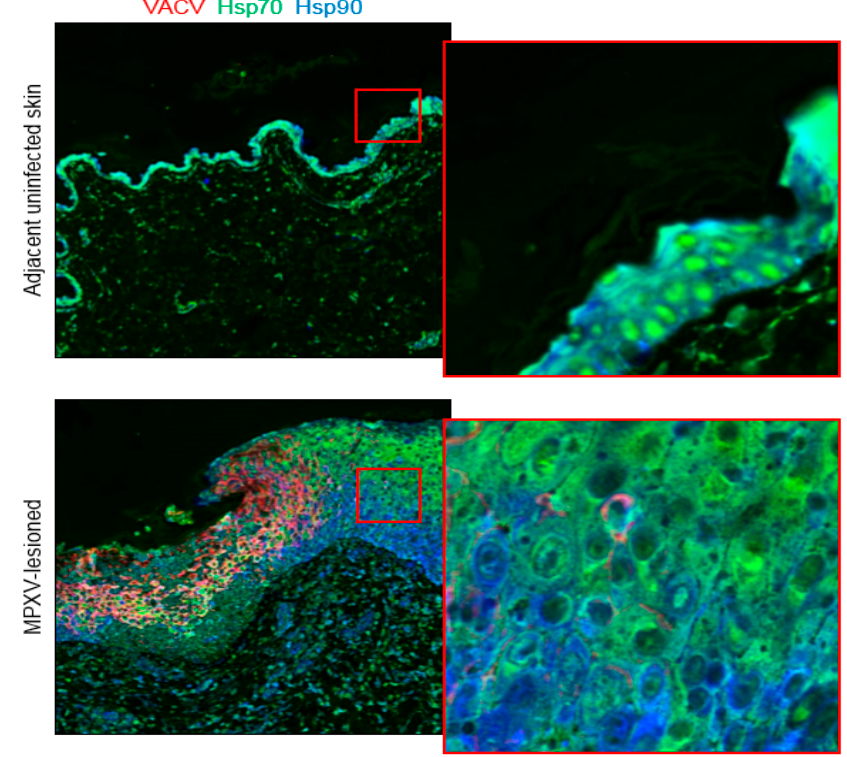
Figure 3. Di ff erential subcellular localization of Hsp70 in adjacent nonlesion vs infected skin regions. In adjacent nonlesion regions, a strong nuclear signal for Hsp70 is observed, whereas in the infected lesion area it is mainly cytoplasmic. For Hsp90, no significant di ff erence in expression was detected in the cytoplasm or nuclei of lesioned skin using IHC or Cell